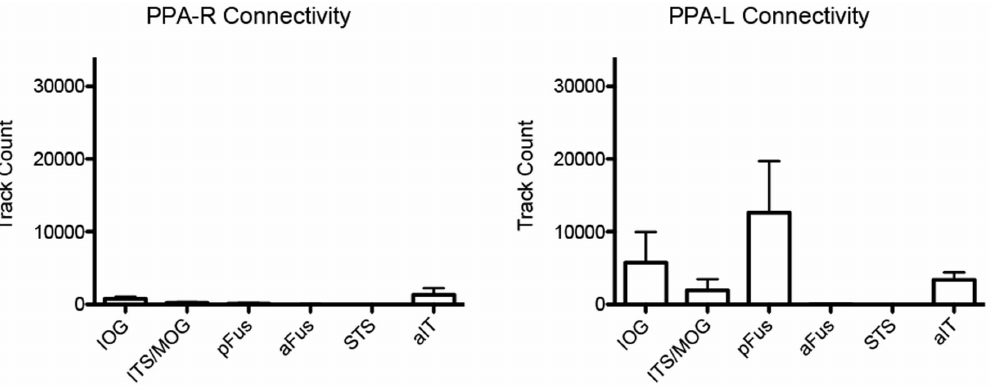
Figure 6. Connectedness (measured by track counts) of the PPA control area to other ROIs. Error bars indicate standard error.